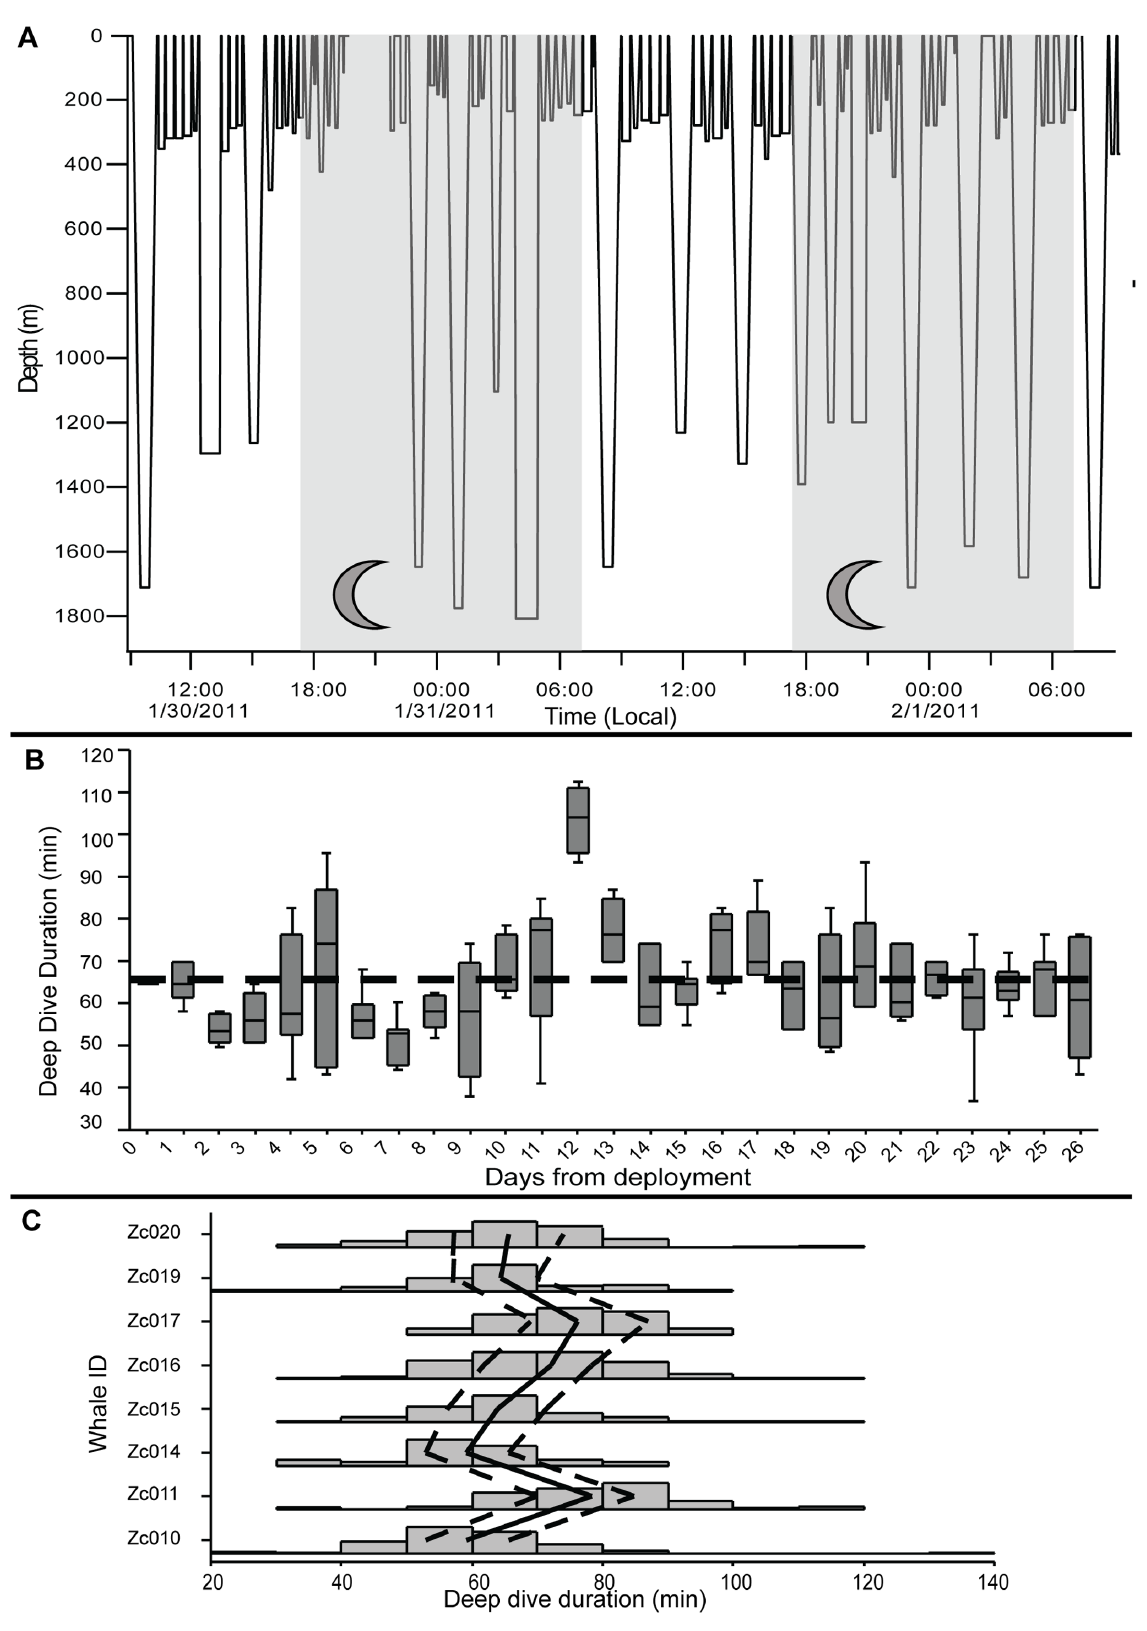
Figure 3. Variation in diving behavior. ( A ) A 48-hr BL dive trace from Zc015, illustrating the pattern of ‘‘deep’’ and ‘‘shallow’’ dives. Darkened areas represent night. The gap in the dive record during the first night period reflects data that were not received via Argos. ( B ) Box plot of deep dive